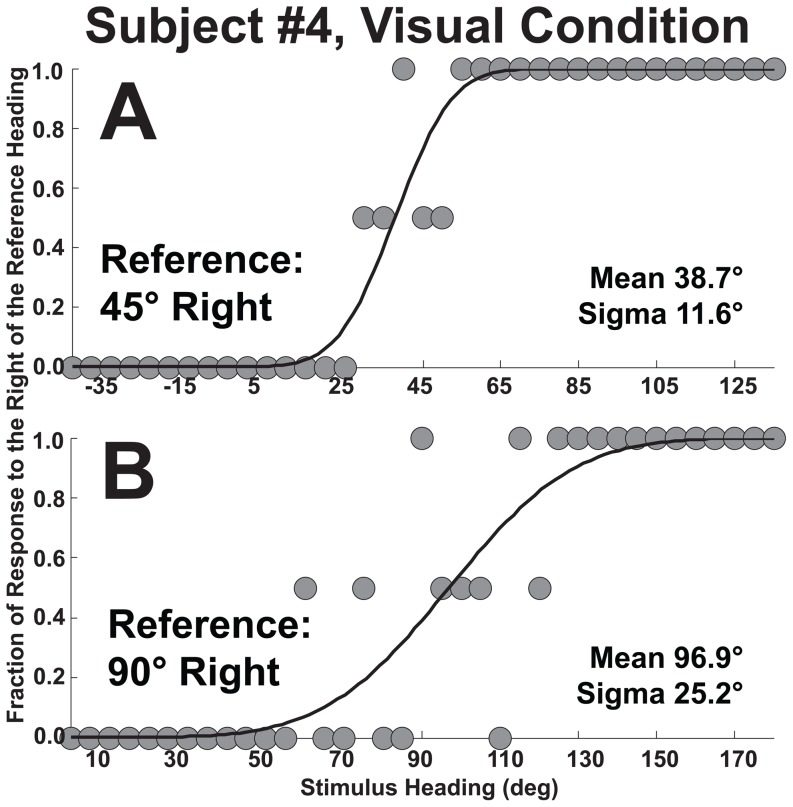
The psychometric method of determining perceived heading.This example is for the visual stimulus in subject #4. Each point represents 2 stimulus presentations. The figure is analogous to Fig. 3 except data from a single subject is shown. Panel A: The reference heading is 45° right. Panel B: The reference heading is 90° right.